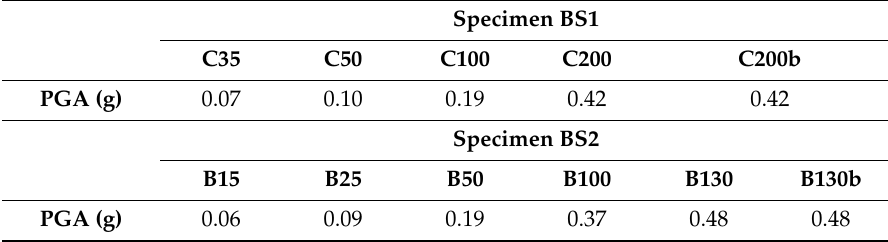
Figure 4. Original accelerogram of the earthquake recorded in the seismic station. Left: Calitri. Right: 142 Bar-Skupstina Opstine. 143 Table 1. The peak-ground acceleration of each seismic simulation. 144